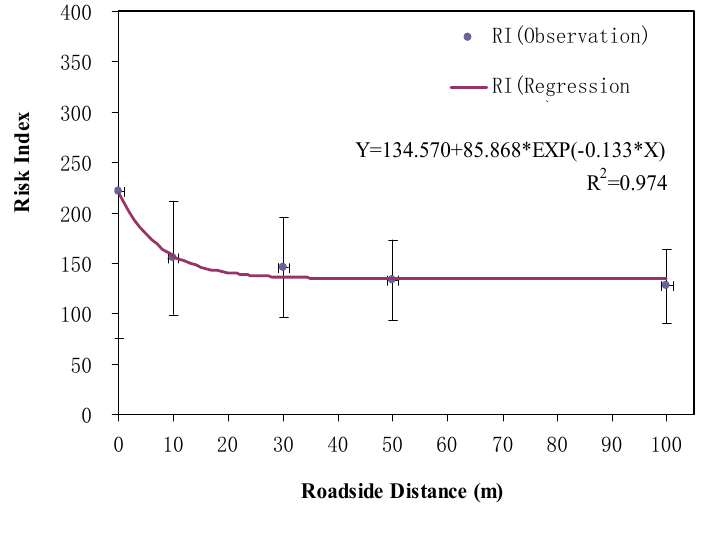
Figure 3. The mean risk indices based on different roadside distances of all sampling